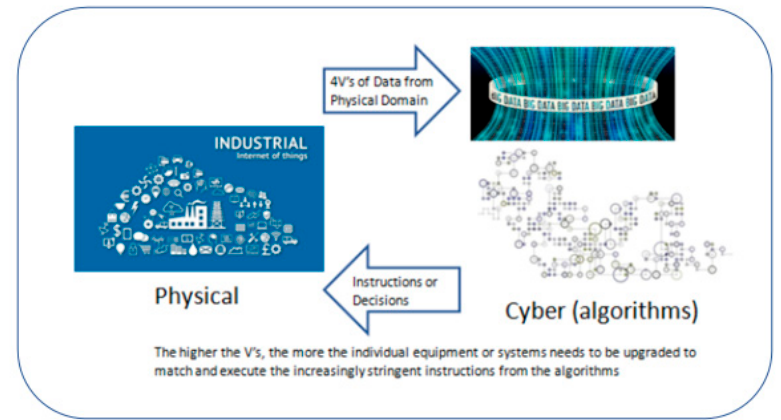
Figure 6. A rendition of the proposed interaction or feedback effects between the physical and cyber domains; higher V’s of data would in turn demand higher processing capabilities in the physical system to execute instructions. This will trigger technology fusion in the individual product technology.